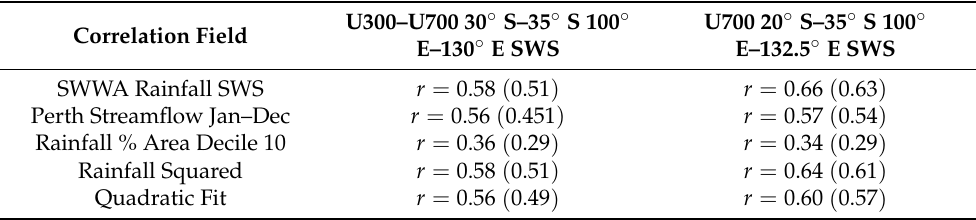
Table 6. Correlations ( r ) , and detrended correlations in brackets, of SWWA rainfall, PAR D10 , stream- flow into Perth dams, rainfall squared and a quadratic fit of rainfall to streamflow with SWS 300 hPa minus 700 hPa zonal wind shear averaged between 30 ◦ S and 35 ◦ S, 100 ◦ E and 130 ◦ E and 700 hPa zonal wind averaged between 20 ◦ S and 35 ◦ S, 110 ◦ E and 132.5 ◦ E. Confidence levels C L > 99% apart from the detrended correlations with PAR D10 for which C L >